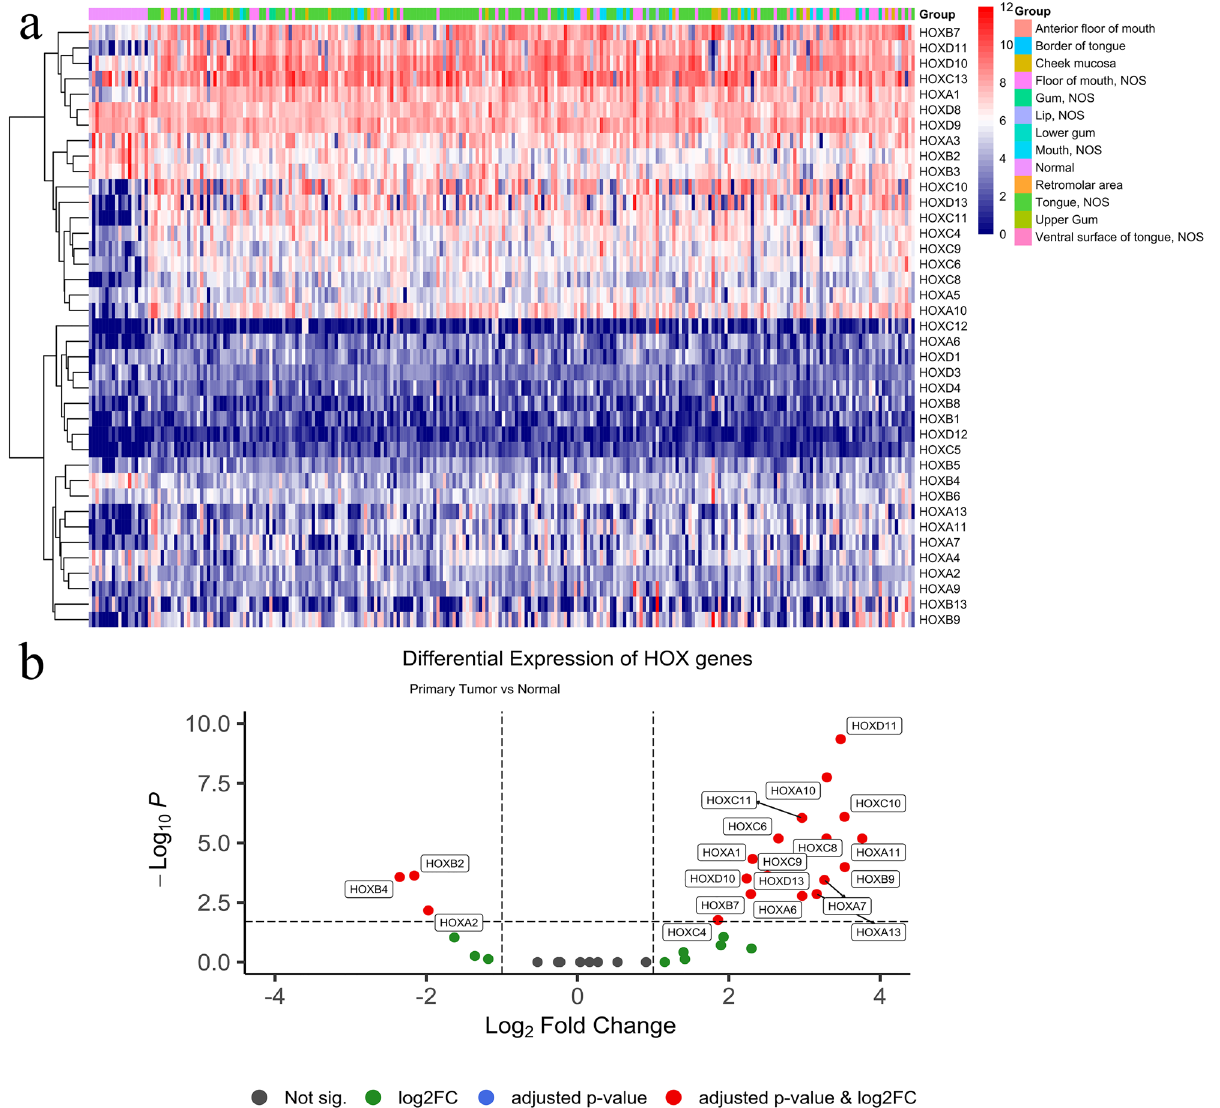
Figure 2. ( a – b ): ( a ) Illustrative heatmap of HOX gene expressions in a panel of normal (n = 18) and tumor (n = 234) specimens analyzed from the TCGA-HNSC derived oral cancer datasets categorized based on their subsites. ( b ) Differentially expressed HOX genes in primary tumors compared to the normal samples were identified using DESeq2 with a log2FC cut-off (− 1 and + 1) factoring 1% FDR to minimize false positives. Results are depicted as a volcano